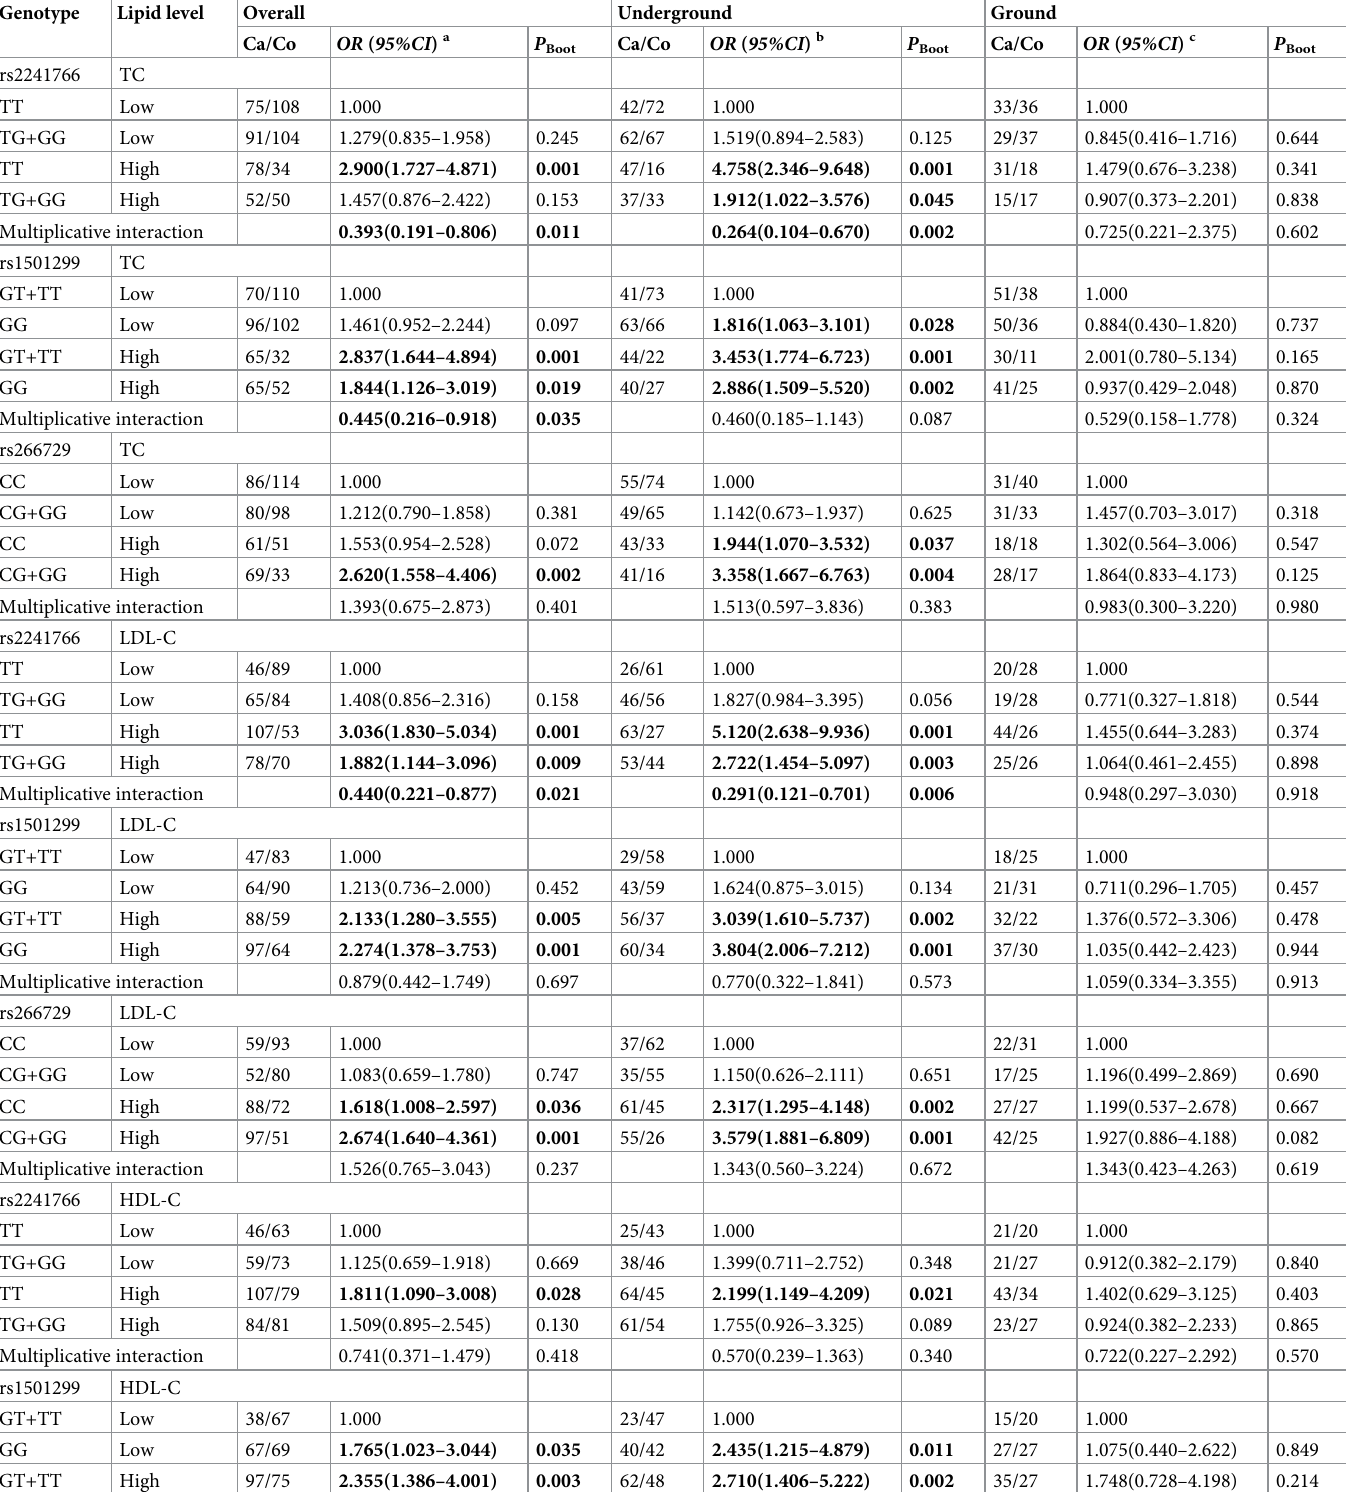
Table 5. Effects of rs2241766, rs1501299, rs266729 interaction with lipid levels on hypertension